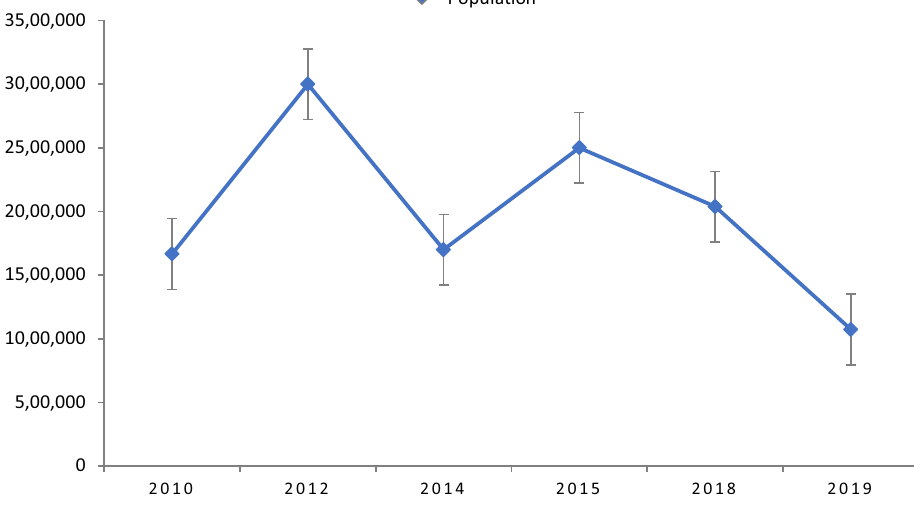
Fig. 8 Annual population estimations (AMA 2014, 2015, 2019; Amoako and Boamah